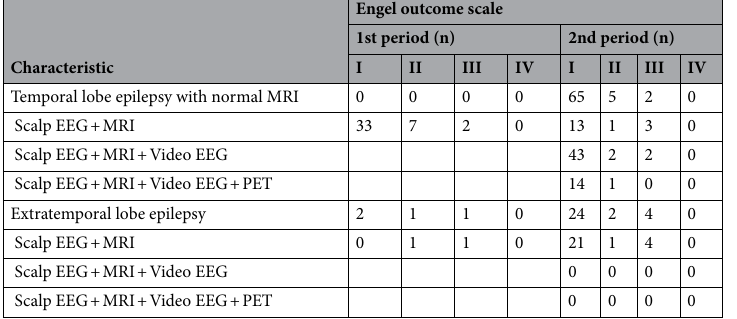
Table 3. Surgical outcome based on the multimodality evaluation. I Class 1, II Class 2, III Class 3, IV Class 4, EEG Electroencephalogram, MRI Magnetic resonance imaging, SPECT Single-photon emission computed tomography, PET Positron emission